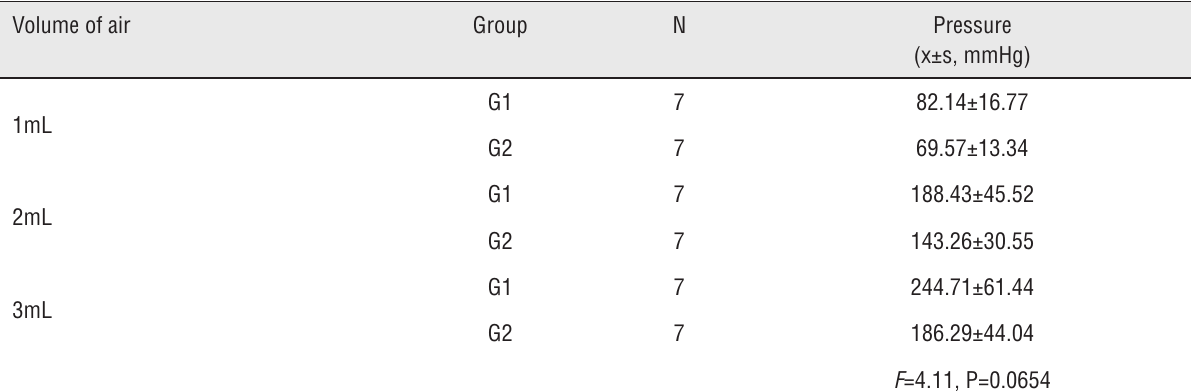
Table 1 - Intraluminal pressures generated by air injection. Volume of air